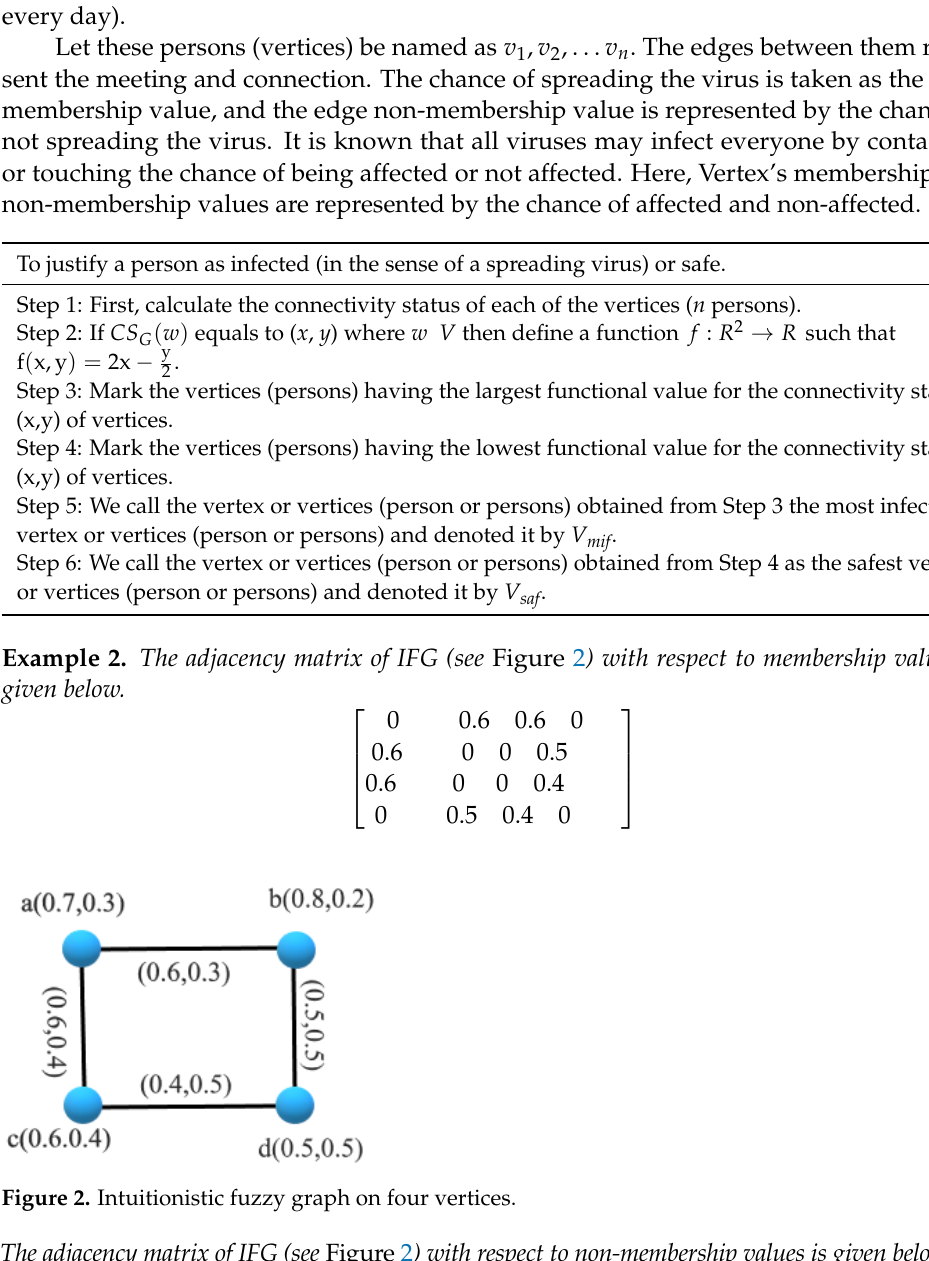
. with respect to the membership 𝐺𝐺 = ( 𝑉𝑉 , 𝐸𝐸 ) matrix of weight on the edge 𝐺𝐺 ’ = ( 𝑉𝑉 , 𝐸𝐸 ’) 𝑛𝑛 × 𝑛𝑛